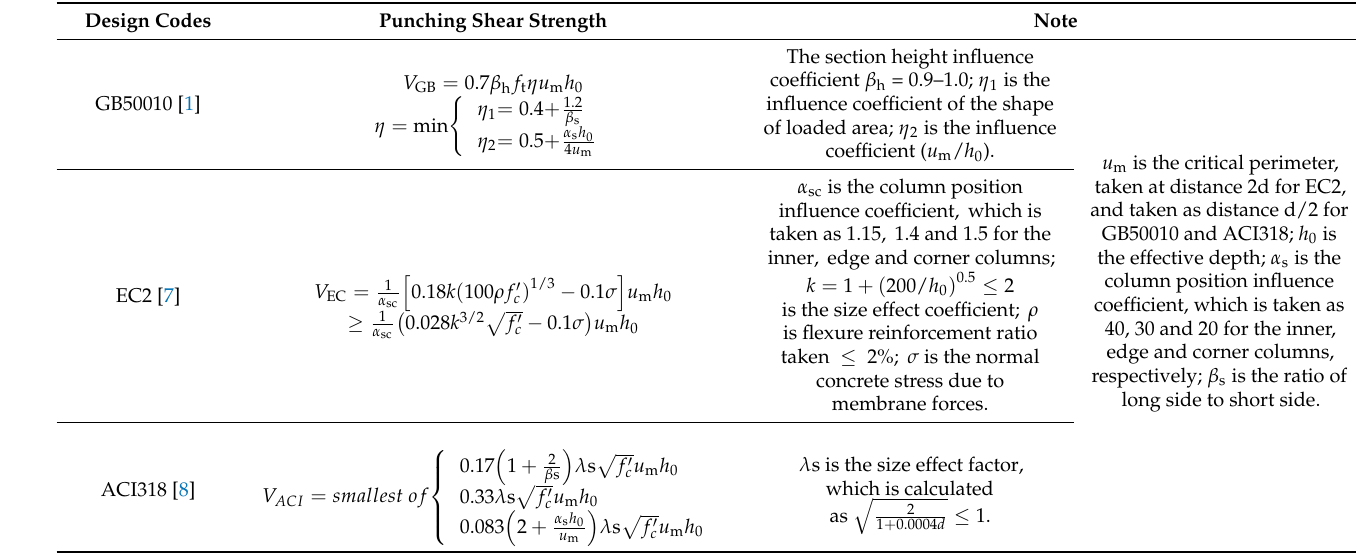
Table 8. Design codes for punching shear resistance.